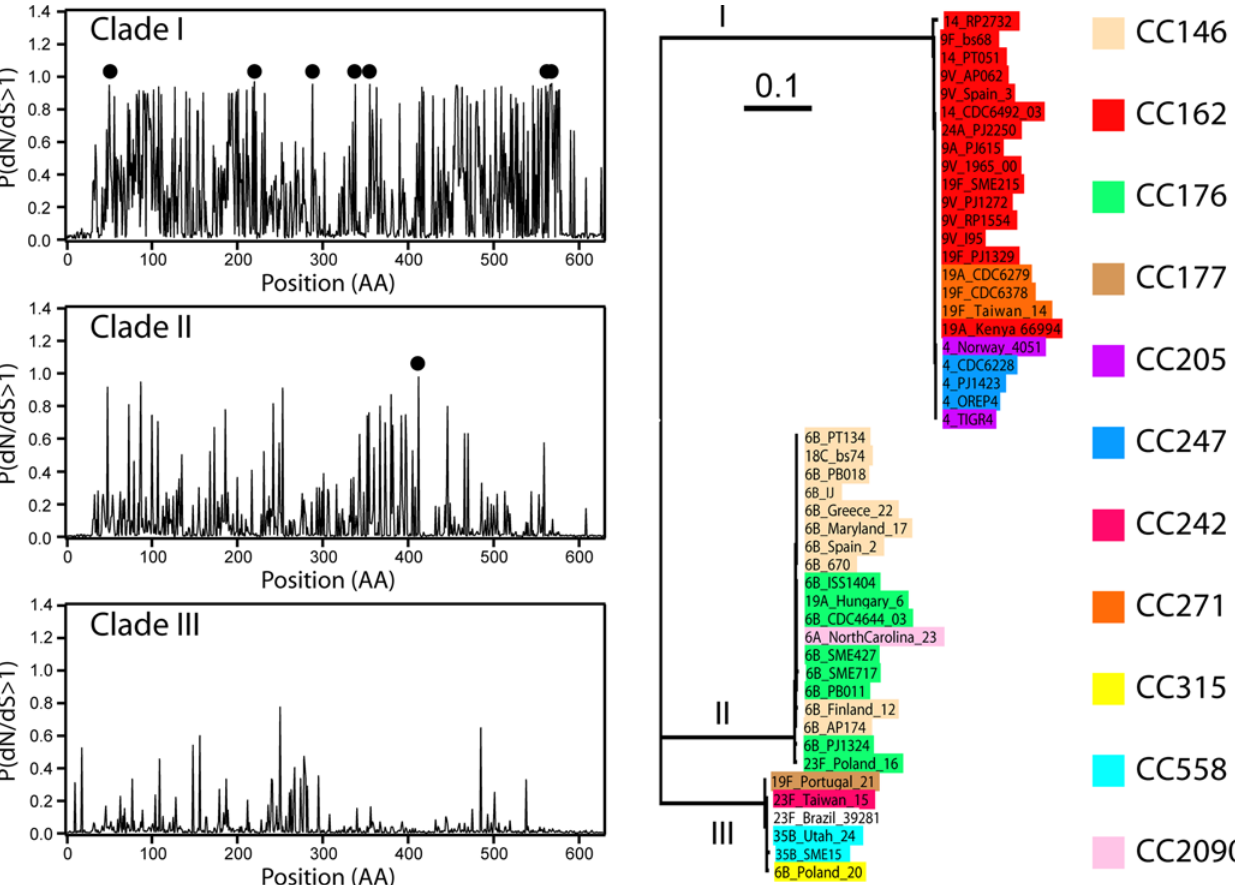
Figure 3. Positive selection on rrgB. Probability P( d N /d S . 1) that a codon is under positive selection in rrgB . The branch-site model was tested separately for the three clades, marked on the phylogenetic tree on the right. From top to bottom: clade I, clade II clade III. The background color of the strain names identifies their MLST classification into clonal complexes. The likelihood ratio test supports the positive selection model only for clades I and II. Sites marked by dark circles are under positive selection with probability exceeding 99%.